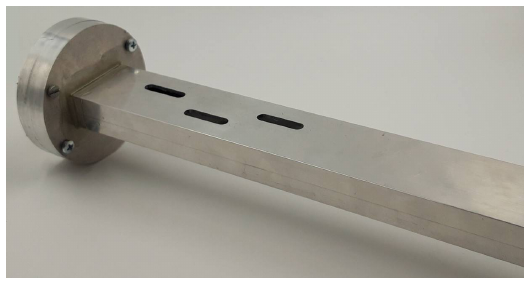
Figure 4. Prototype of the aluminum antenna. Table 1. The antenna dimensions.